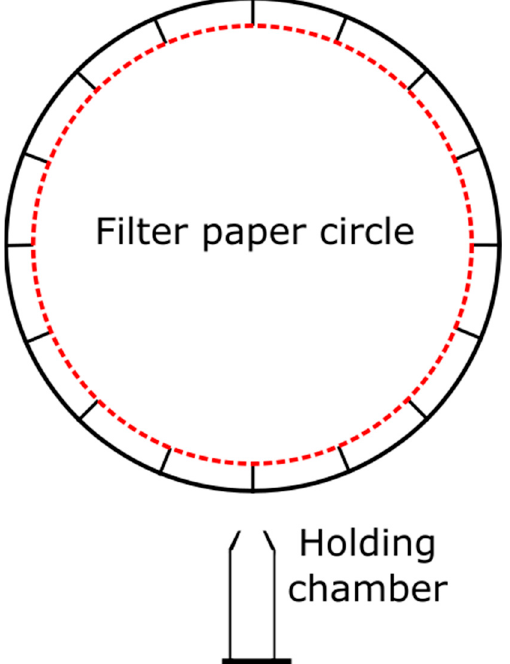
Figure 1. Graphical illustration of the experimental design used for testing trail-following of Western carpenter ants, Camponotus modoc , black garden ants, Lasius niger , and European fire ants, Myrmica rubra , in response to their own trail pheromone or a complex blend of six trail pheromones (see Table 1). To account for body size di ff erentials of large ants ( Ca. modoc ) and small ants ( La. niger ; M. rubra ), bioassay arenas were large (64 cm wide × 44 cm long × 10 cm high) or small (circular, 15 cm diam × 1 cm high), and the diameter of the filter paper was 18.5 and 9 cm, respectively. Pheromone trails were applied to the filter paper along the red dotted line (which was absent in bioassays).